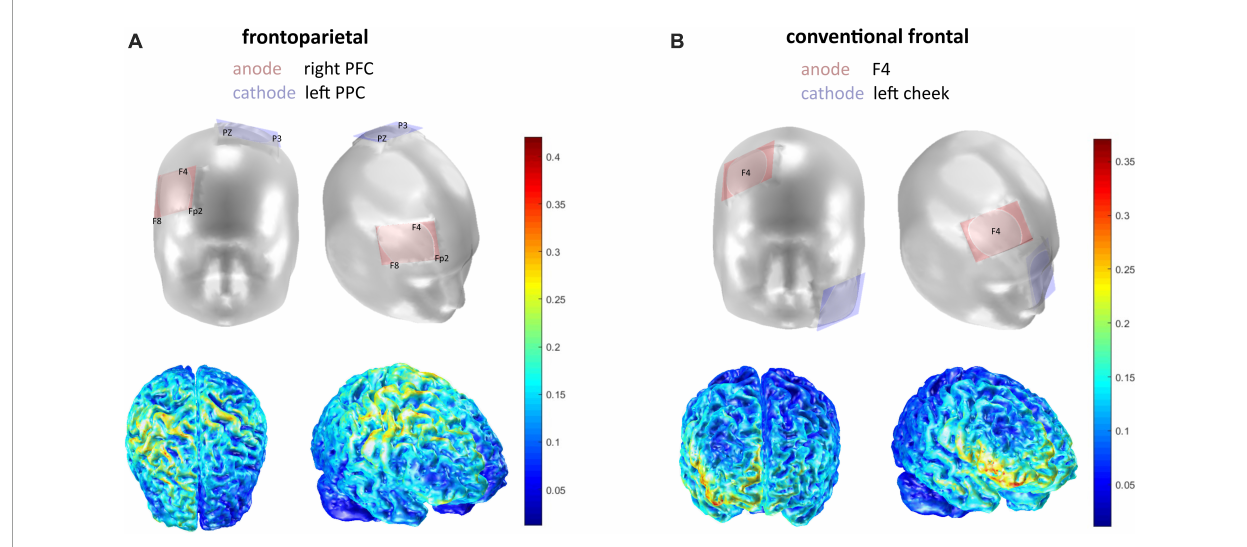
FIGURE2 Electrode montages in frontal and lateral view. (A) Frontoparietal stimulation application. (B) Conventional stimulation application. The current density is depicted in Joule beneath (see colorbar for scale). Simulation of electrode montage and current density was executed with COMETS